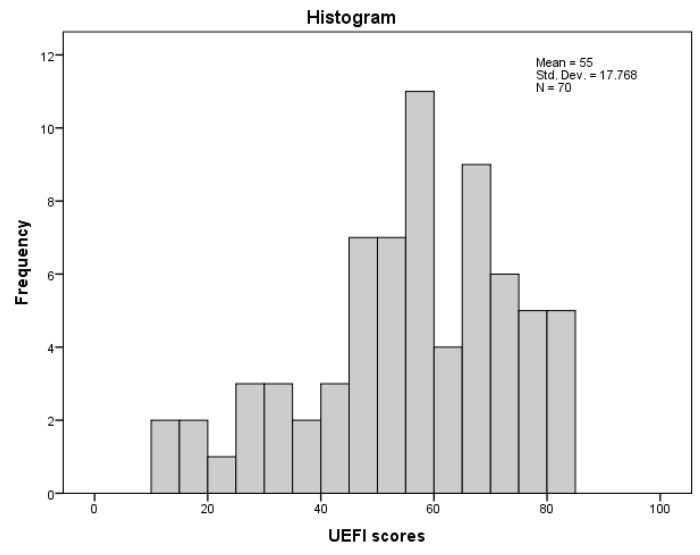
Figure 1. Frequency histogram of UEFI scores in the first testing session. Table 1. Characteristics of participants ( N = 70).